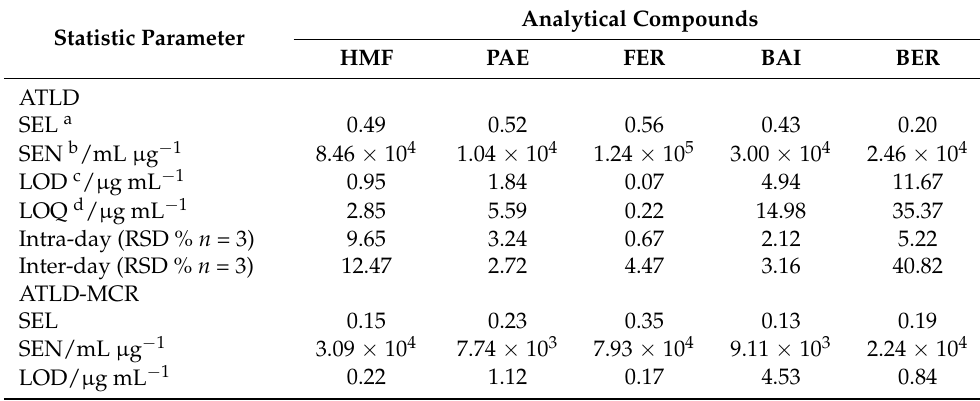
Table 2. The figures of merit and precision for determination of five analytes in selected WQY samples using ATLD and ATLD-MCR